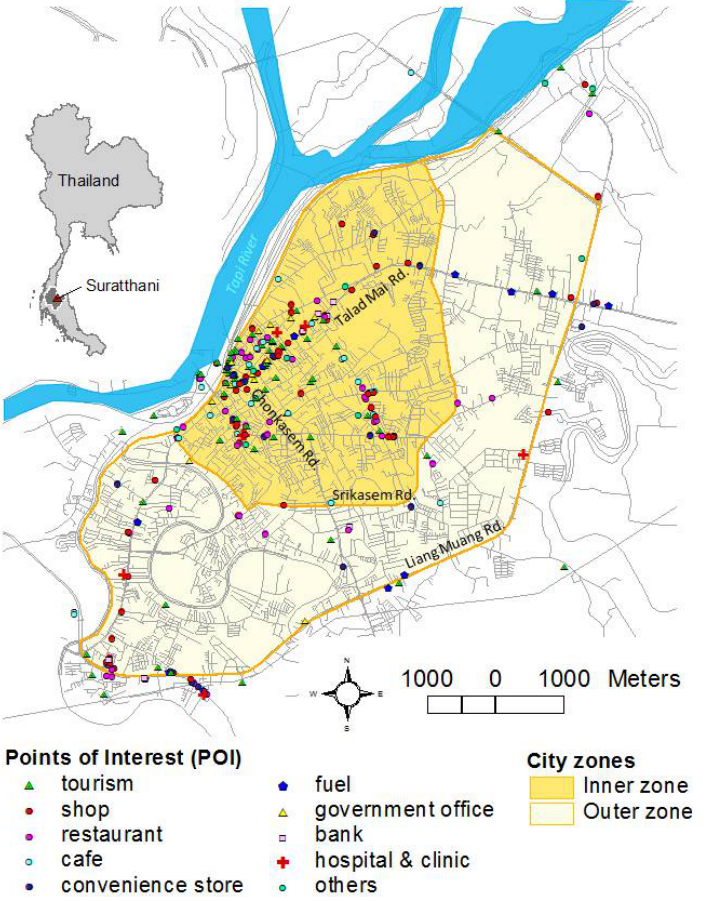
Figure 1. Location of the study area and the spatial pattern of the points of interest (POI) are distributed in the inner and outer zones of Surat Thani city.